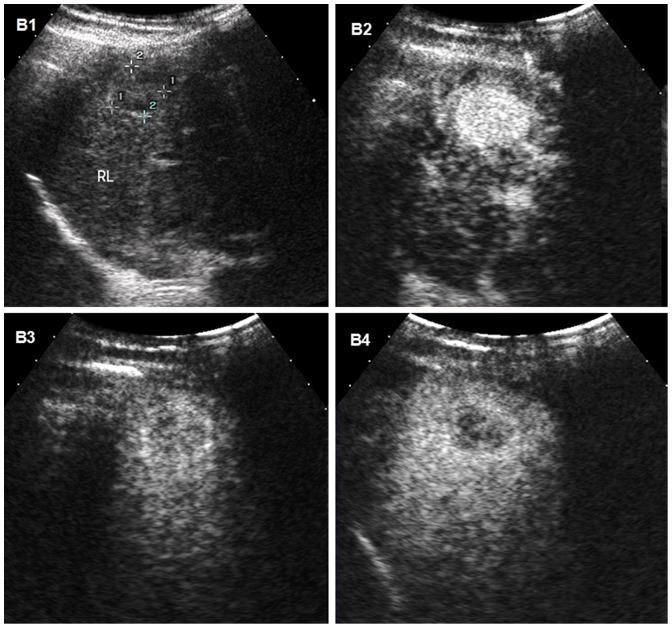
Hepatocellular carcinoma (HCC) with moderate differentiation in a 31-year old man with cirrhosis.B1 Conventional ultrasound displays a hypoechoic nodule of 20-out appearance at 95 seconds after injection of contrast agent. B4 The lesion appears as mild wash-out 179 seconds after the administration of contrast agent.